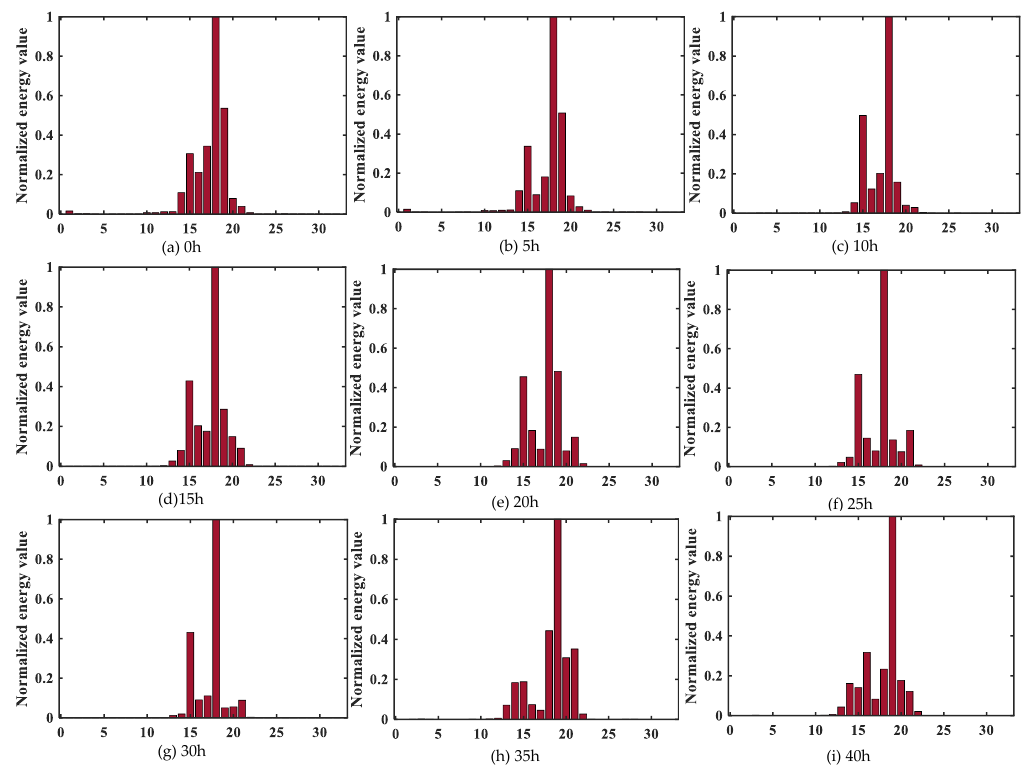
Figure 8. Wavelet packet energy characteristics under different corrosion degrees.